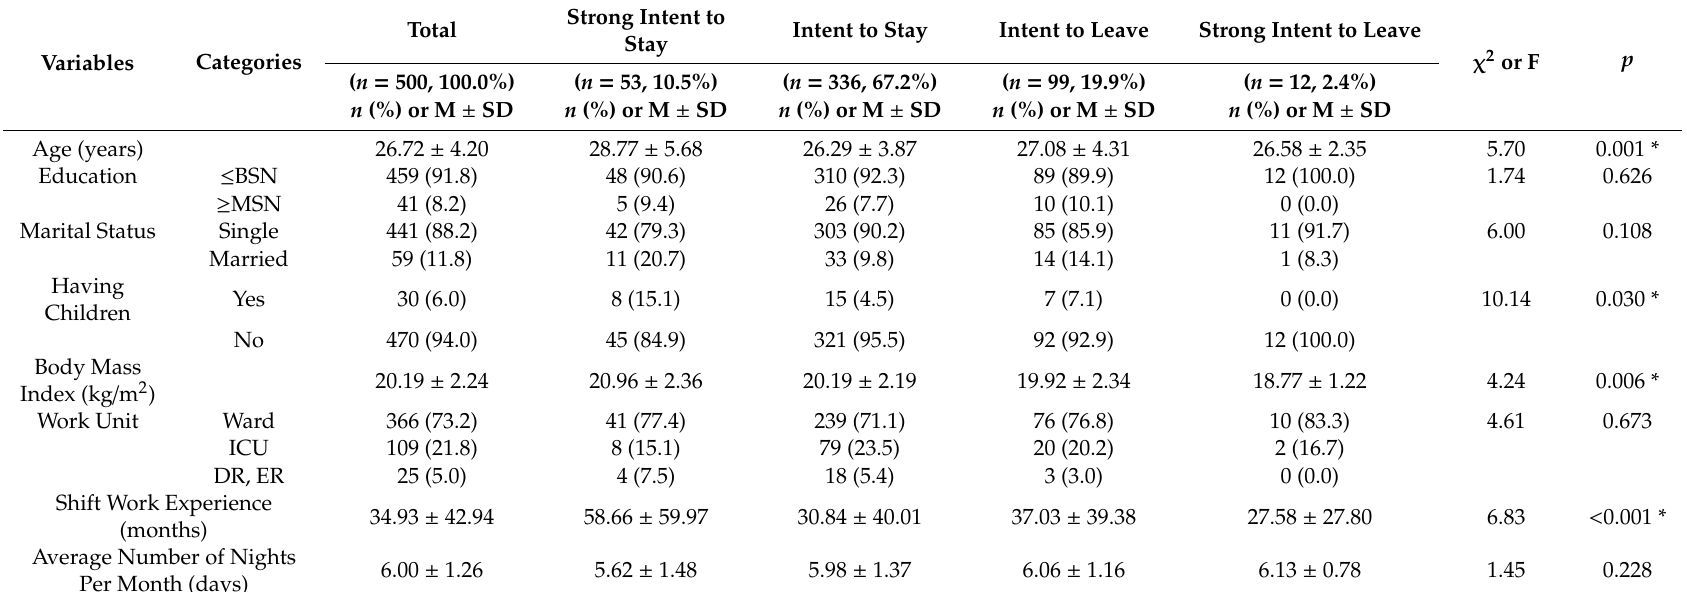
Table 1. Demographic and job-related characteristics by turnover intention ( n =